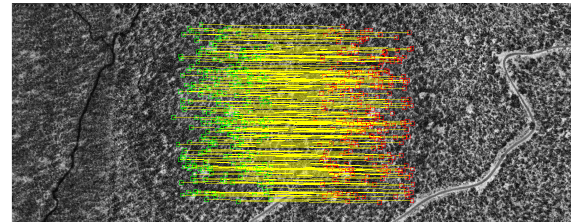
Figure 12: Matches for combined elevation-intensity